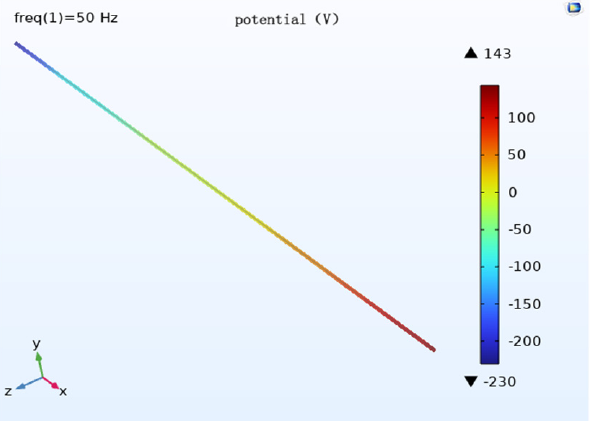
Figure 17. Transmission line to a ground height of 18 m when the pipeline cathodic protection potential is distributed.